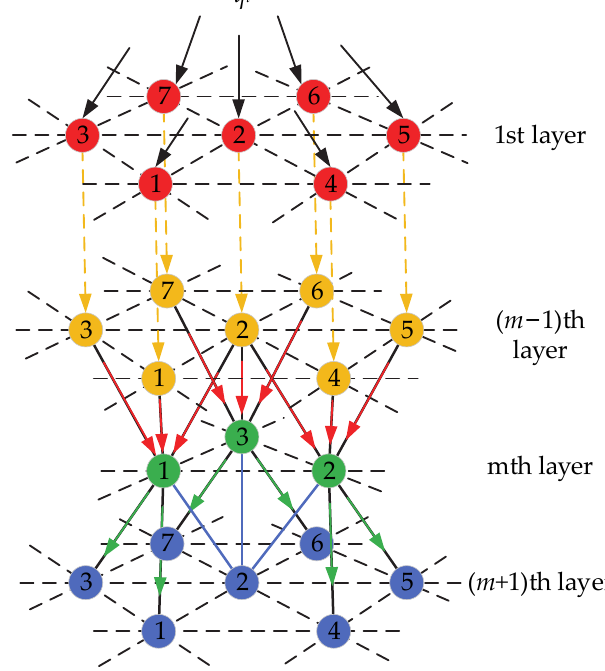
Figure 6. Hcp internal force transfer model.